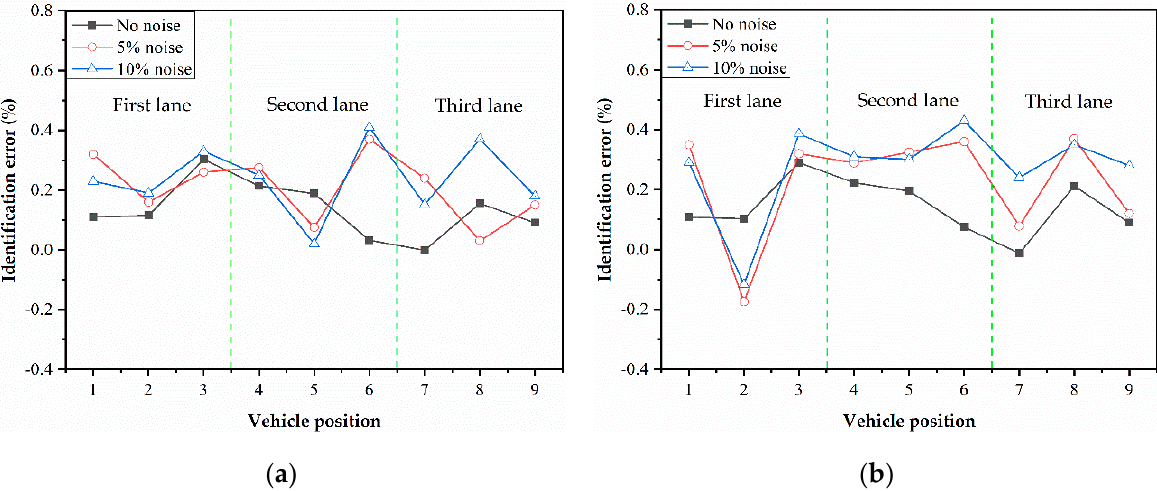
Figure 11. Identification error under different levels of noise with the load of: ( a ) 20 kg, ( b ) 30 kg.